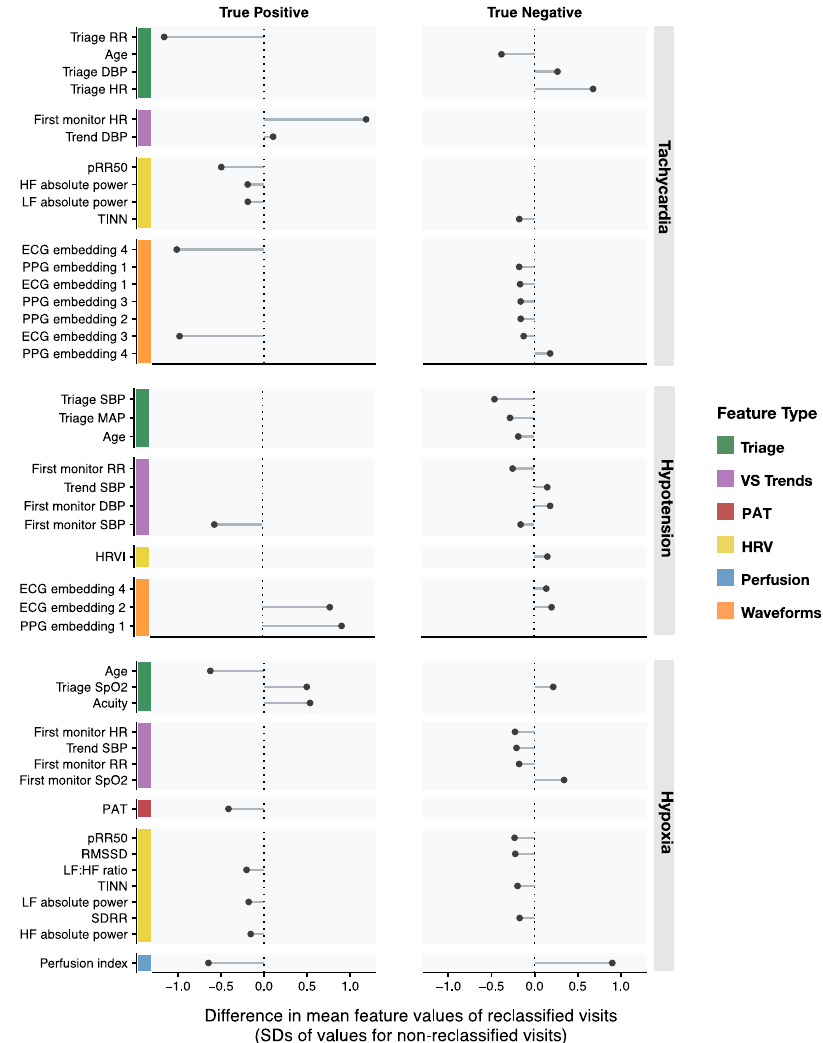
Fig. 4 Differences in feature values among correctly reclassi fi ed visits. We isolated the visit cohorts correctly classi fi ed by the best- performing model, but incorrectly classi fi ed by the baseline triage model. For each reclassi fi ed cohort, we identi fi ed the features that differed signi fi cantly from the non-reclassi fi ed cohorts ( p < 0.05, two-sided t-tests). Points represent differences in mean feature values for correctly reclassi fi ed visits, scaled to each variable ’ s distribution among non-reclassi fi ed